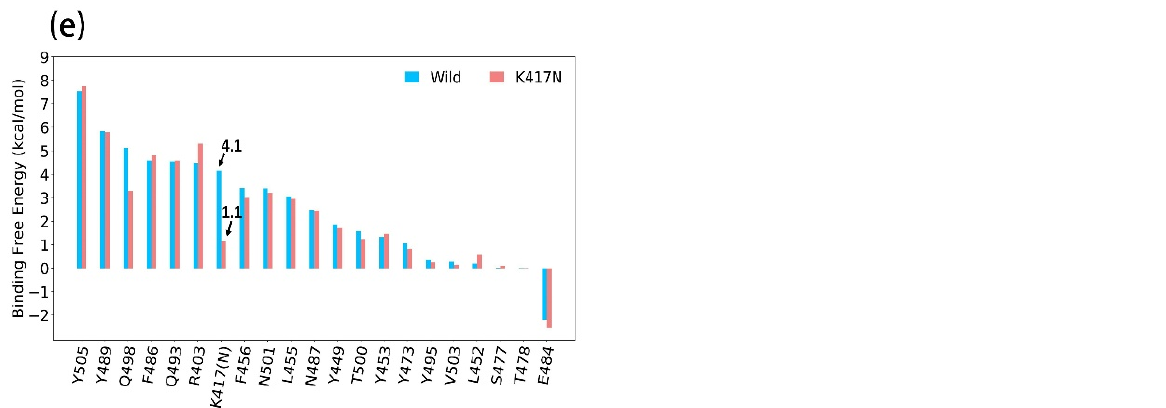
Figure 1. Residue-specific binding free energy data of the S protein between the wild type and the different mutants in binding to ACE2 from the ASGB calculation. (Calculated results were averaged over 5 trajectories separately). The ( a – e ) show the specific binding affinity contributions of interface residues on S protein for wild type and N501Y, E484K, L452R, T478K and K417N complex.